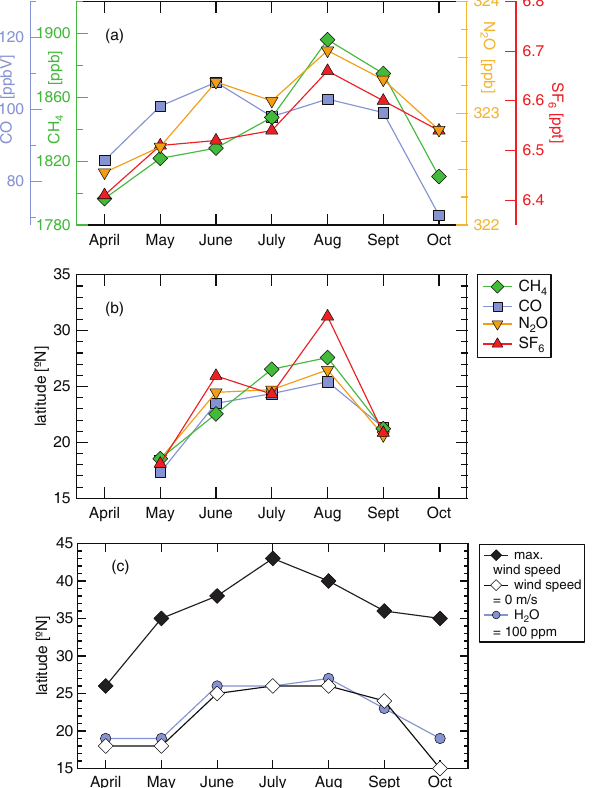
Fig. 45. Observations of the southern Asian summer monsoon plume from the CARIBIC project: (a) Maximum mixing ratios of mixing ratios of CH , CO, N O, and SF observed in summer 2008 south Fig. 7. (a) Maximum CH 4 , CO, N 2 O, and SF 6 observed in summer 2008 south of 40 ◦ N, 4 2 6 of 40 ◦ N. For April and October, when no monsoon plume is apparent, the monthly mean values showing the plume enhancements from May–September (monthly mean values are shown for April and October); (b) Latitudinal po- are plotted. (b) Latitudinal position at which the maximum mixing ratios of CH , CO, N O, and 4 2 sition at which the maximum mixing ratios of CH 4 , CO, N 2 O, and SF were observed. (c) Latitudinal position of the maximum wind speed in the westerly jet 6 SF 6 were observed. (c) Latitudinal position of the maximum wind and the latitude where the zonal wind speed is 0 m / s, both indicating the latitudinal position of speed in the westerly jet (on the northern side of the regional mean the anticyclone. The latitude where a H O mixing ratio of 100 ppm is observed indicates the anticyclone), and the latitude where the zonal wind speed is 0m/s, 2 northern extension of the strong convection. together indicating the latitudinal position of the regional anticy- clone. All measurements were in the altitude range 8–12.5km. The 2084 latitude where the H 2 O mixing ratio exceeds 100ppmv (equivalent to 100µmol/mol) is also shown, indicating the northern extension of the strong monsoon convection (from Schuck et al., 2010, copy- right 2010 by the European Geophysical Union, reproduced with